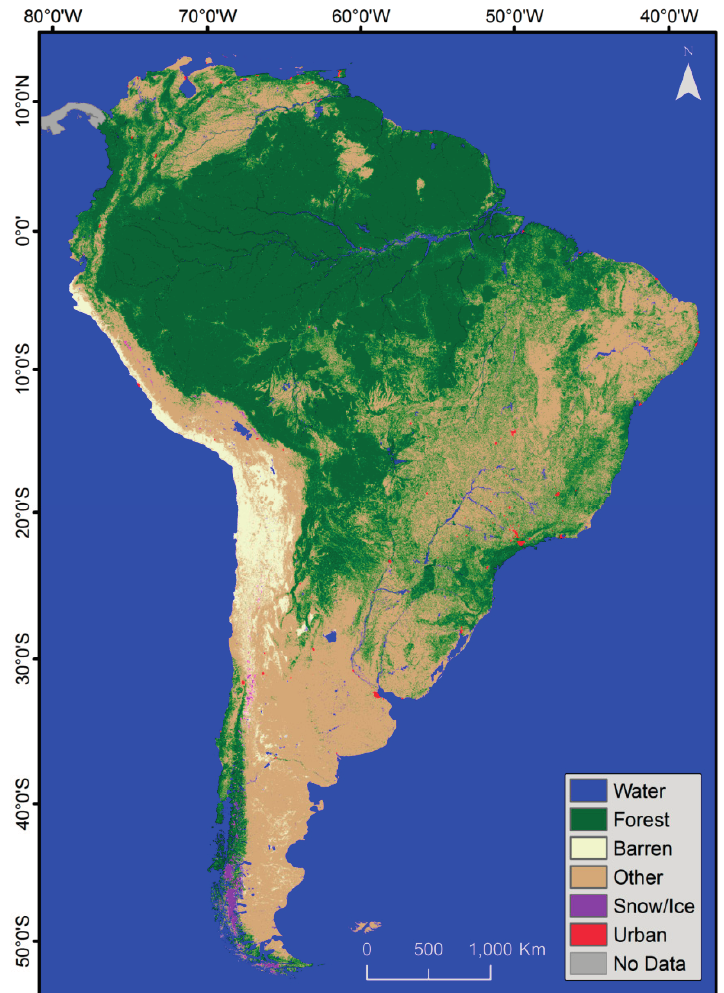
Figure 4. 2010 South America 30 m land cover map prepared using Landsat 30 m satellite